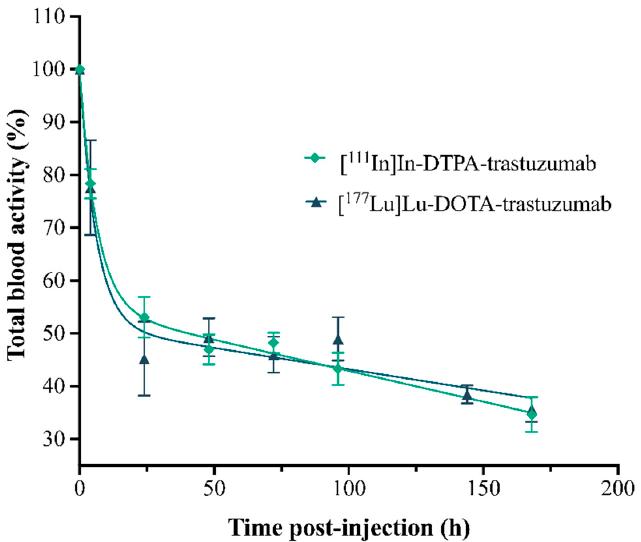
Figure 5. Percentage curves of the activities of the RICs, [ 111 In]In-DTPA-trastuzumab and [ 177 Lu]Lu-DOTA-trastuzumab, in total blood of normal female BALC/c mice. Values are expressed as mean ± SEM ( n = 4–5). Table 1. Pharmacokinetic parameters of [ 111 In]In-DTPA-trastuzumab and [ 177 Lu]Lu-DOTA-trastuzumab determined in normal female BALB/c mice ( n = 4–5).